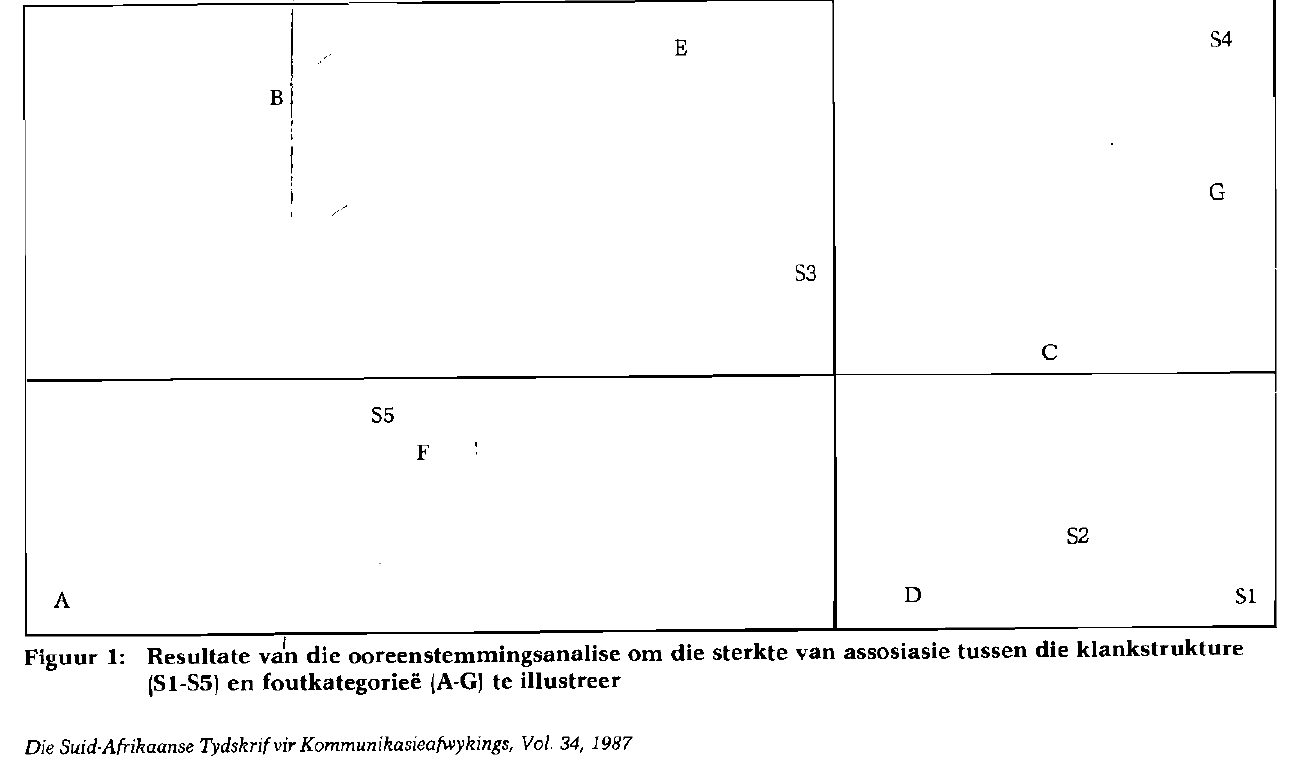
figuur 1) en die verskillende eenhede (kyk figuur 2) word af- gelei van die afstand tussen die twee punte op die grafiese voorstelling.